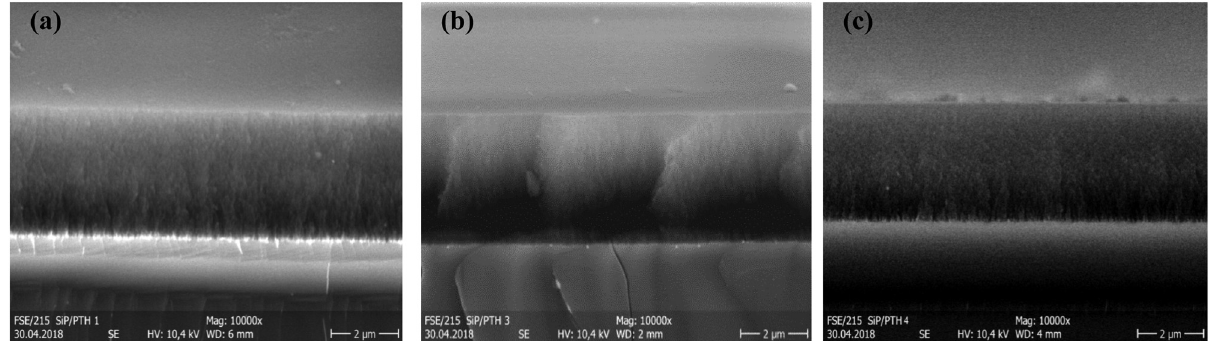
Figure 4: SEM images of PTh/oxide PSi samples prepared with a scan rate of 50 mV · s − 1 : ( a ) 2 VCs, ( b ) 6 VCs, and ( c ) 24 VCs.